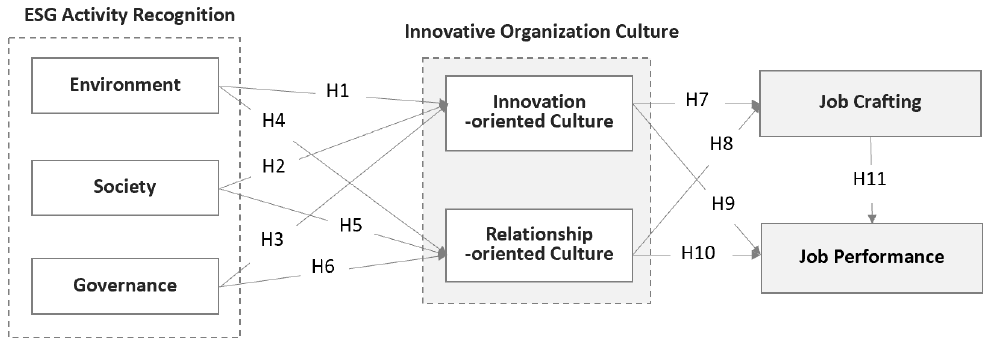
Figure 1. Research model.